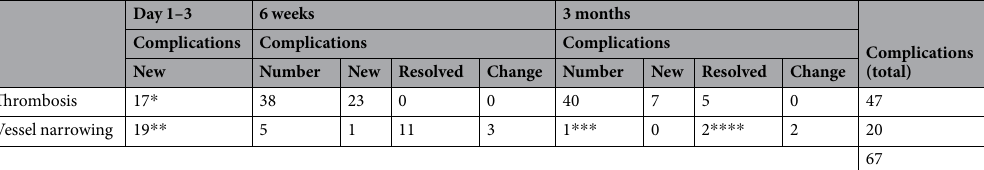
Table 4. Numbers and types of vascular complications during the first 3 months after IRE. IRE, Irreversible Electroporation;